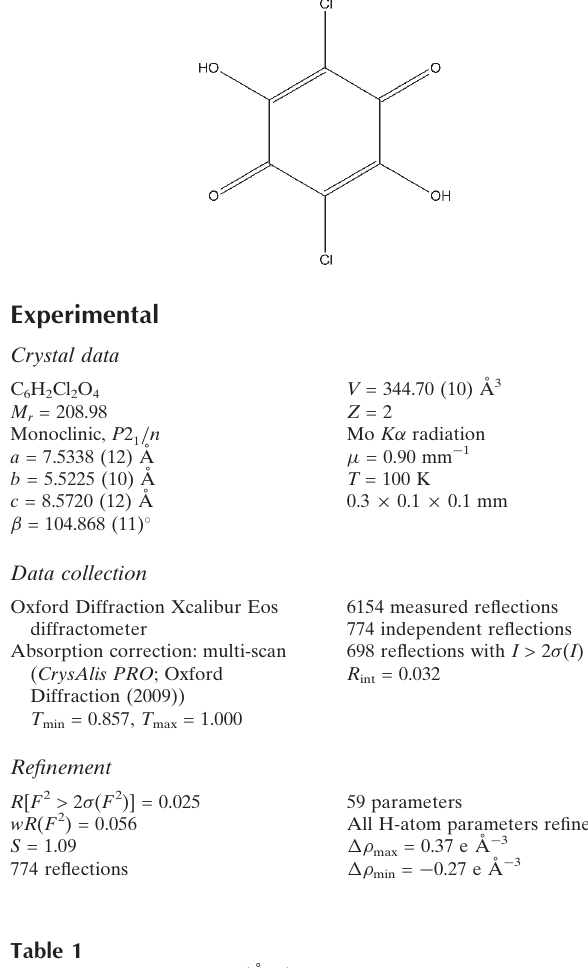
Hydrogen-bond geometry (A˚ , (cid:3)